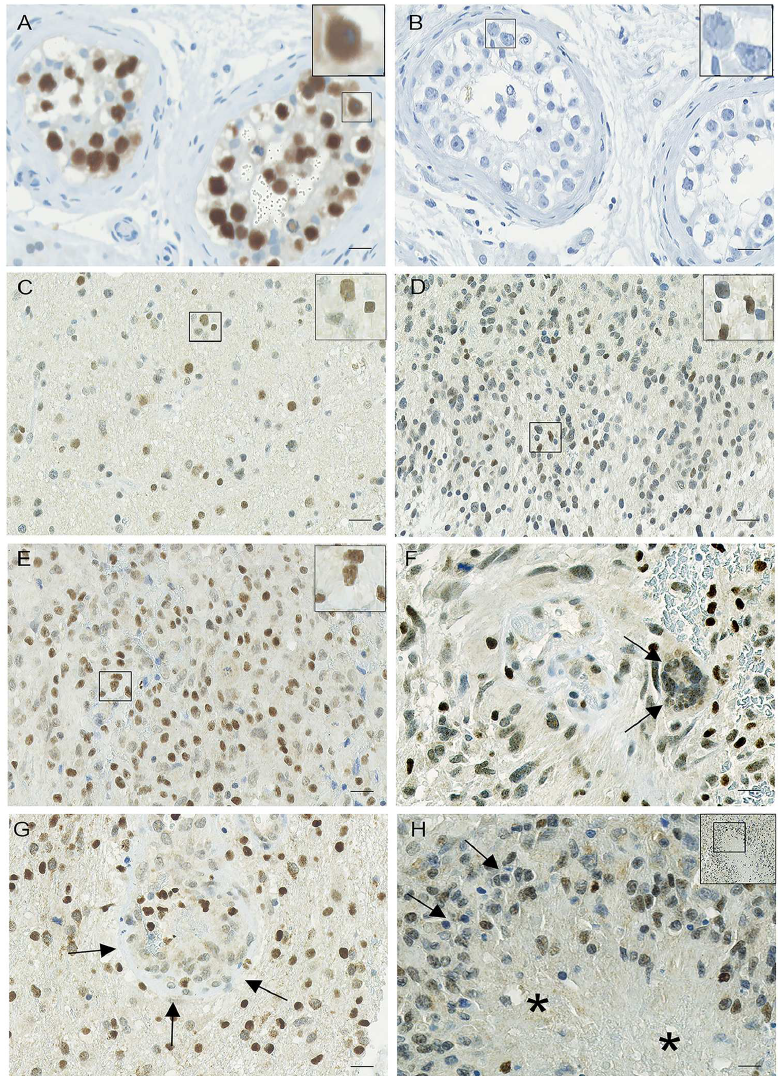
Fig 2. Oct-4 immunohistochemical expression in astrocyticbrain tumors. (A) The positive seminoma tissue control showedan intense and specific nuclear staining. (B) Omission of the primary antibody abolishedall stainingreaction. Representative Oct-4 immunostaining with high expression levels in (C) diffuse astrocytomas, (D) anaplastic astrocytomas and (E) glioblastomas. (F) Multinuclear giant cell (arrows) and (G) glomeruloidtufts (arrows) in glioblastomas showedpositive staining of a fraction of the cells. (H) Pseudopalisadingcells (arrows) aroundnecrosis (asterisk) without enhancedstaining. Scale bar indicates (A-H) 50 μ m,